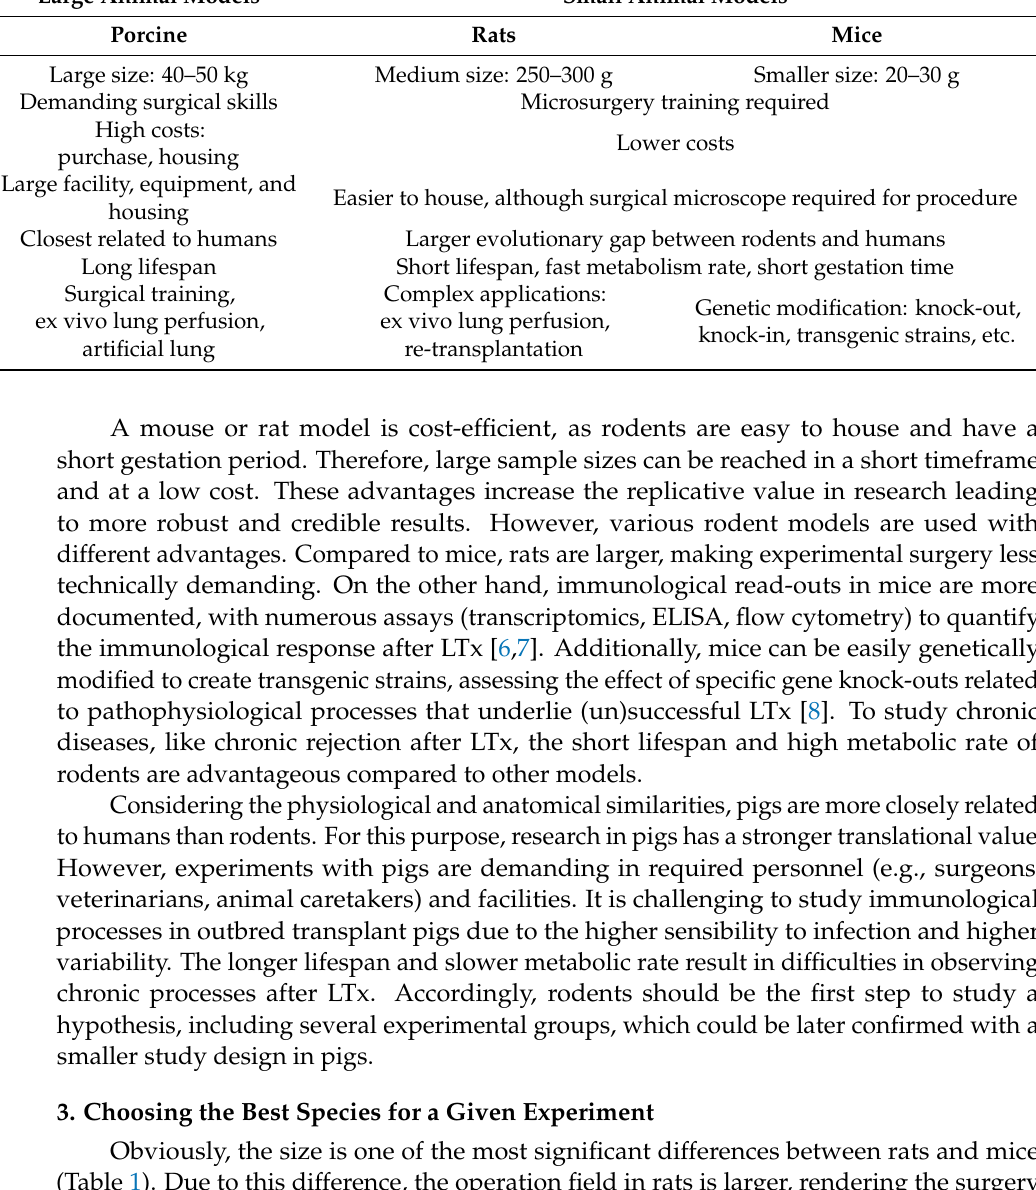
Table 1. Differences between large and small animal LTx models and between rats and mice. Large Animal Models Small Animal